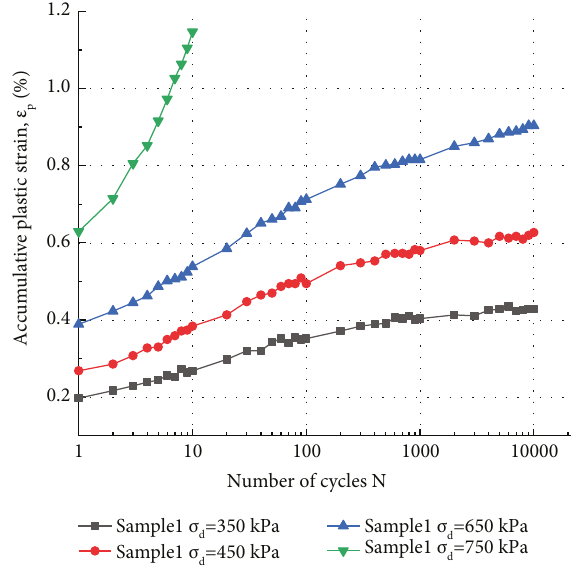
Figure 1: Accumulative plastic strain ε